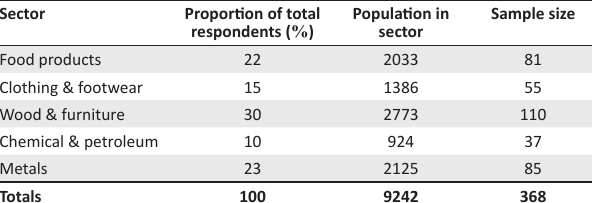
TABLE 1: Sample size per